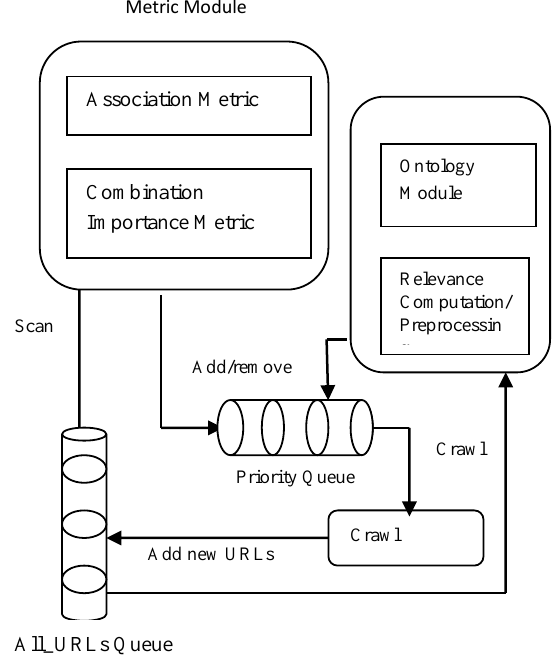
Figure 2. Prototype architecture of ontology based focused